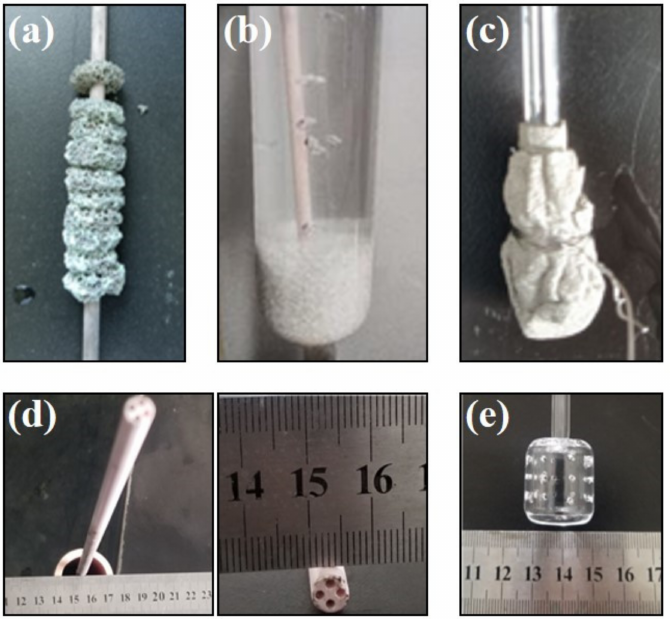
Figure 3. ( a ) Ni foam string; ( b ) quartz sand; ( c ) nickel mesh; ( d ) four-hole gas pipe; and ( e ) integrated disperser device.